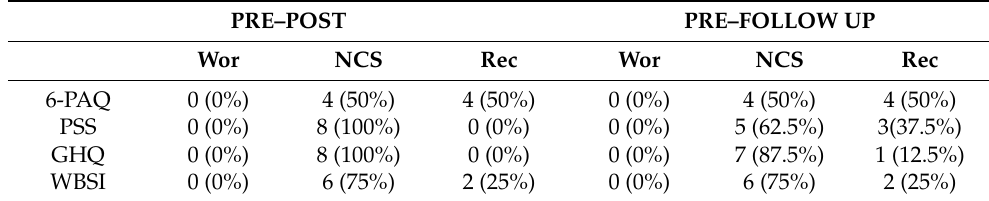
Table 5. Total (and percentage) of patients classified into each clinical significance category by the Jacobson– Truax method based on scales’ scores calculated across two time periods in the intervention